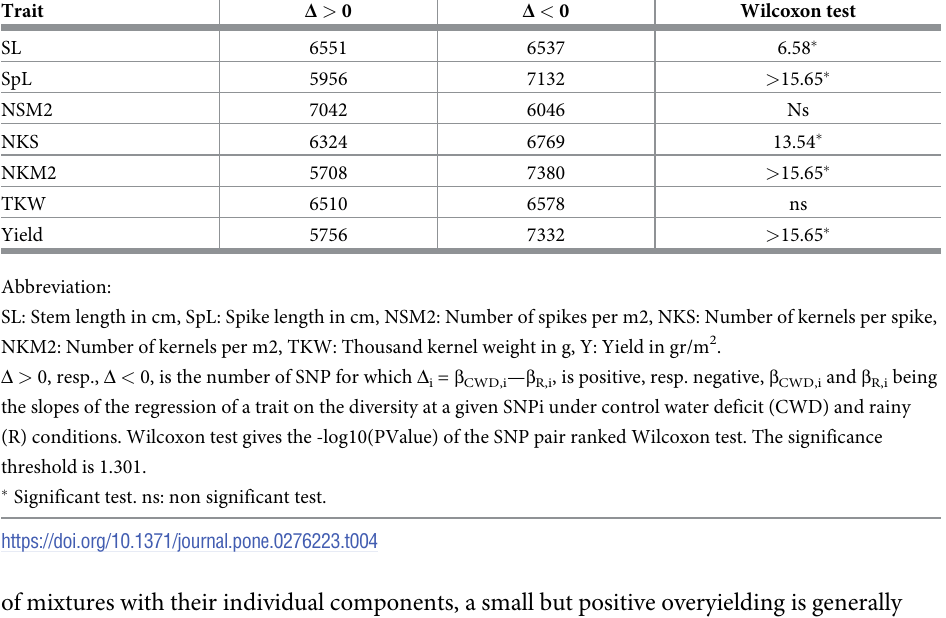
Table 4. Difference number and effect of the positive and the negative sum of the difference of slopes in CWD and in R (delta) and the p-value of their wilcoxon’s test. Trait Δ >